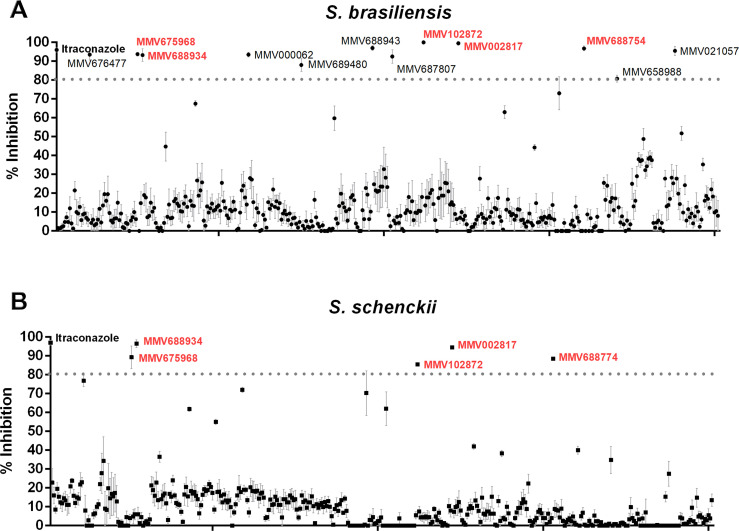
High-content screening of the Pathogen Box library.Percentage of growth inhibition of (A) Sporothrix brasiliensis and (B) Sporothrix schenckii after exposure to 1 μM of the library compounds for 48 hours. Data represent the mean ± SEM and are fully described in S1 Table.